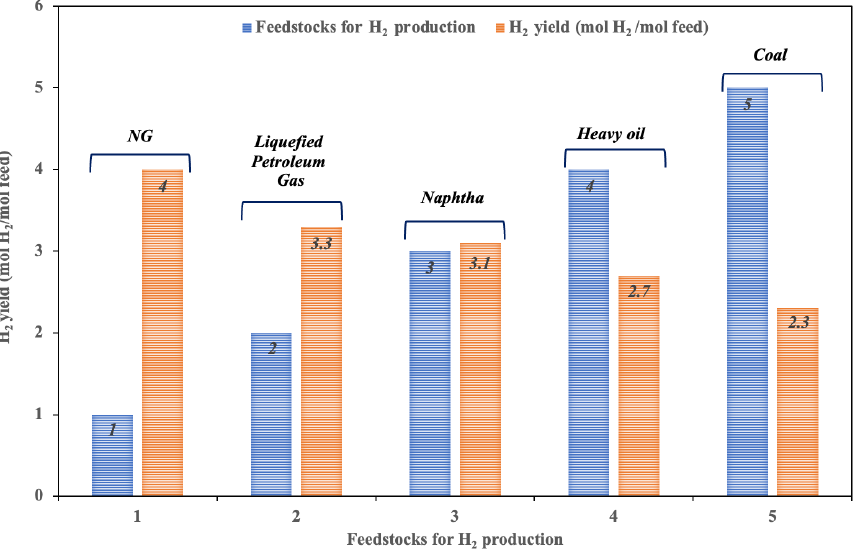
Figure 5. Energy demand comparison among different sources. Table 4. Hydrogen production costs.